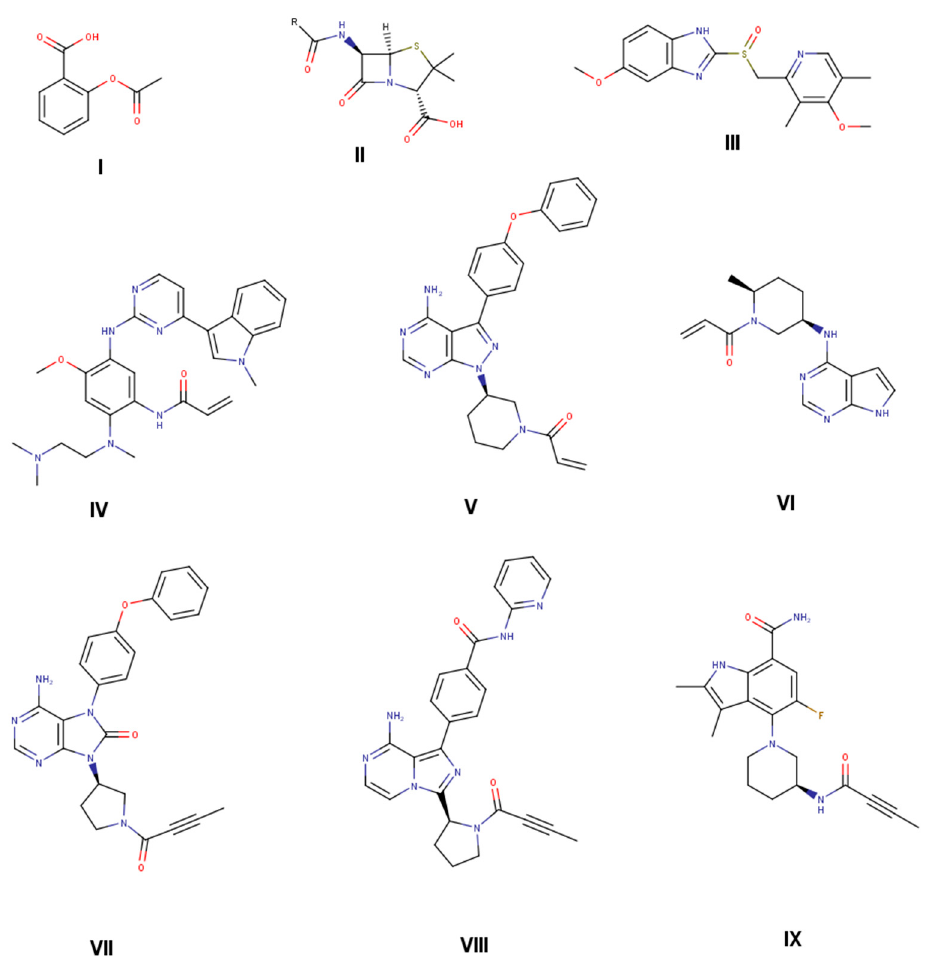
Figure 1. Selected approved drugs that are on the market with covalent mode of action identified after product launch (aspirin ( I ), penicillin G ( II ), and omeprazole ( III ) [18,37]). Selected targeted covalent inhibitors (TCIs) on the market designed to covalently interact with target protein (osimertinib ( IV ) [21], ibrutinib ( V ) [22], ritlecitinib ( VI ) [25], tirabrutinib ( VII ) [23], acalabrutinib ( VIII ) [24]), and in phase II clinical trials (branebrutinib ( IX ) [6]).